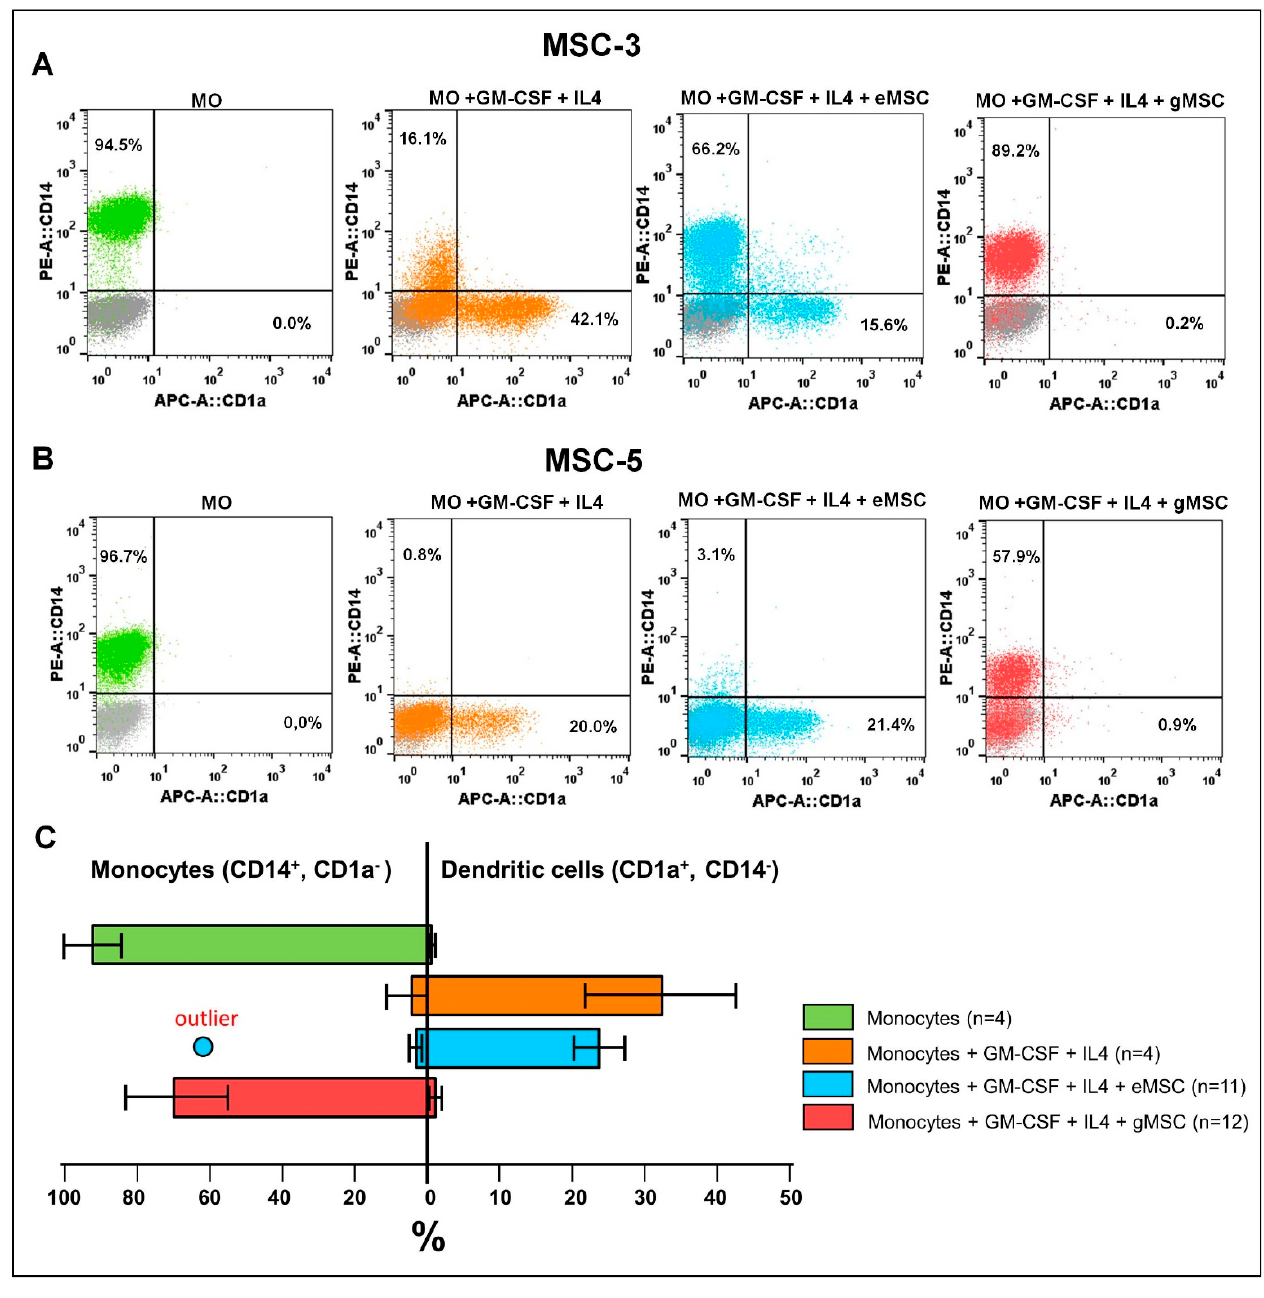
Figure 3. Effect of stromal cells from eutopic and ectopic endometrium upon the differentiation of dendritic cells (DCs) in vitro. Monocytes (MO) were co-cultured with stromal cells of eutopic (eMSC) or ectopic (gMSC) endometrium in the presence of GM-CSF and IL4 (monocytes/MSC ratio 5:1). After 4 days in co-culture, the cells were double-stained with fluorescent MoAbs against CD14 and CD1a and analyzed by flow cytometry to calculate the percentage of monocytes and DCs. ( A , B ) Results for co-cultures with MSC-3 and MSC-5 (typical dot plots). Gray dots denote isotype controls. ( C ) Processed data combining all measurements of six pairs of MSC co-cultures presenting the percentage of cells in the subpopulations and SD.